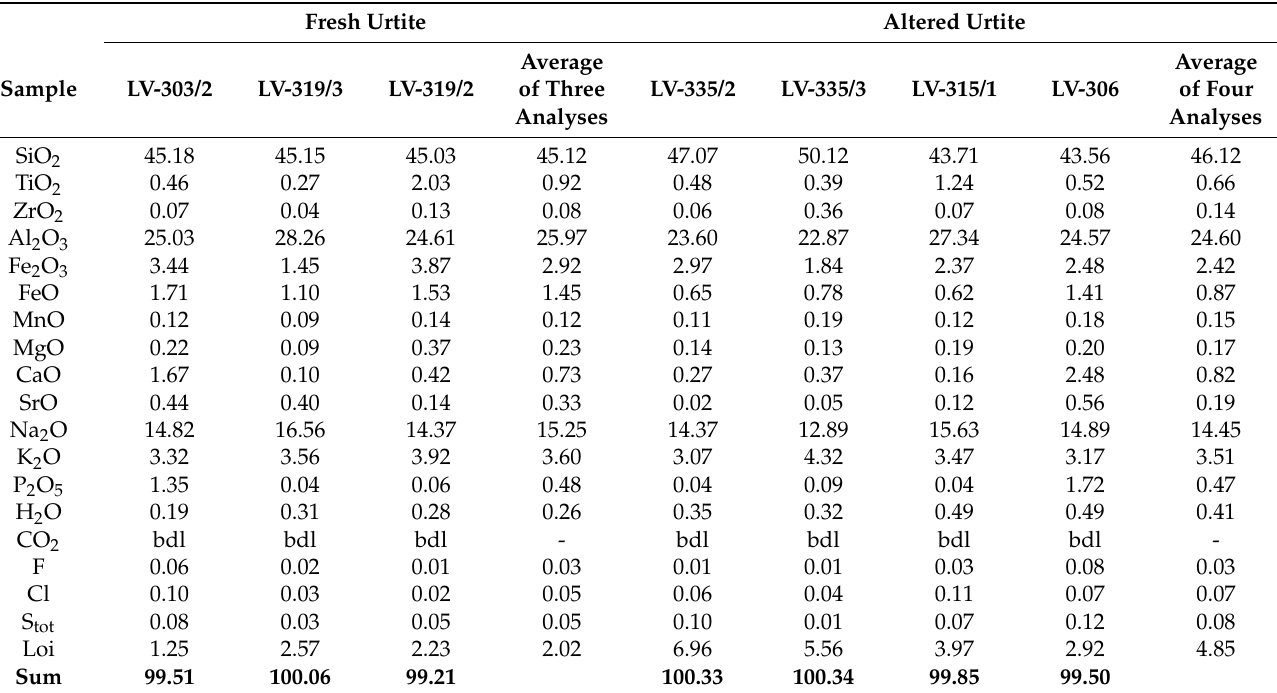
Table 8. Chemical compositions of fresh and altered urtite from Layered complex